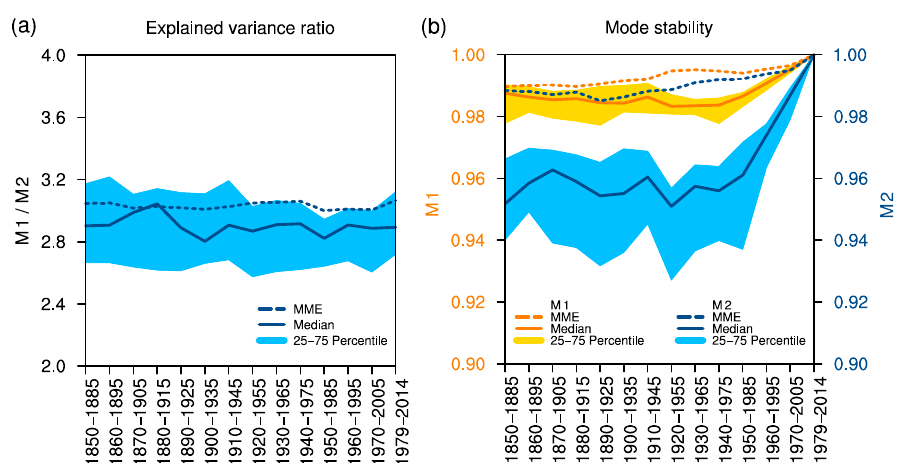
Figure 6. Mode stability during different modelled climatology among all the models. ( a ) Ratios of the explained variance of M1 to M2 in individual models and the MME mean. The horizontal axis represents 14 sliding modelled climatology covering the period from 1850 to 2014. ( b ) The PCCs between the MV-EOF pattern for 1979–2014 climatology and the pattern during different climatology. The dash curves in ( a ) and ( b ) refers to the MME results. The solid curves and blue shadings indicate the median and the 25- to 75-percentiles of the 21 models.